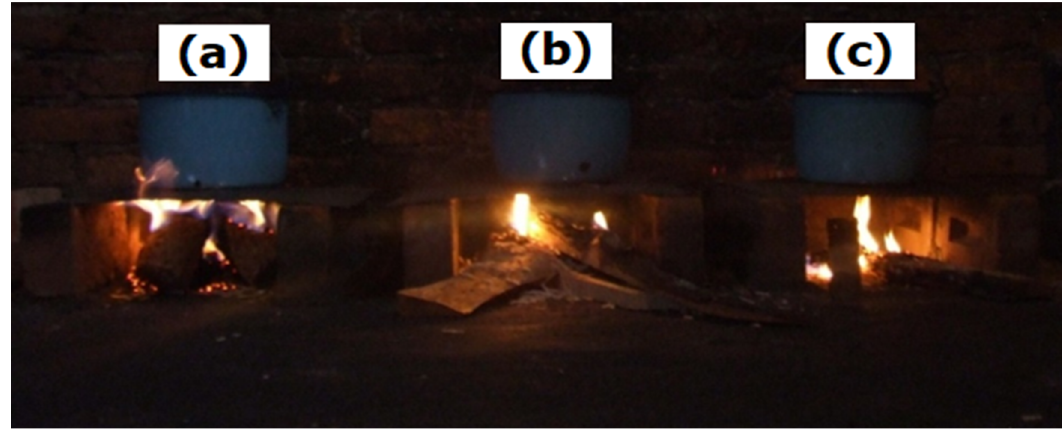
Figure 9. Combustion of the three fuels tested: ( a ) briquette; ( b ) pine firewood; ( c ) oak firewood.